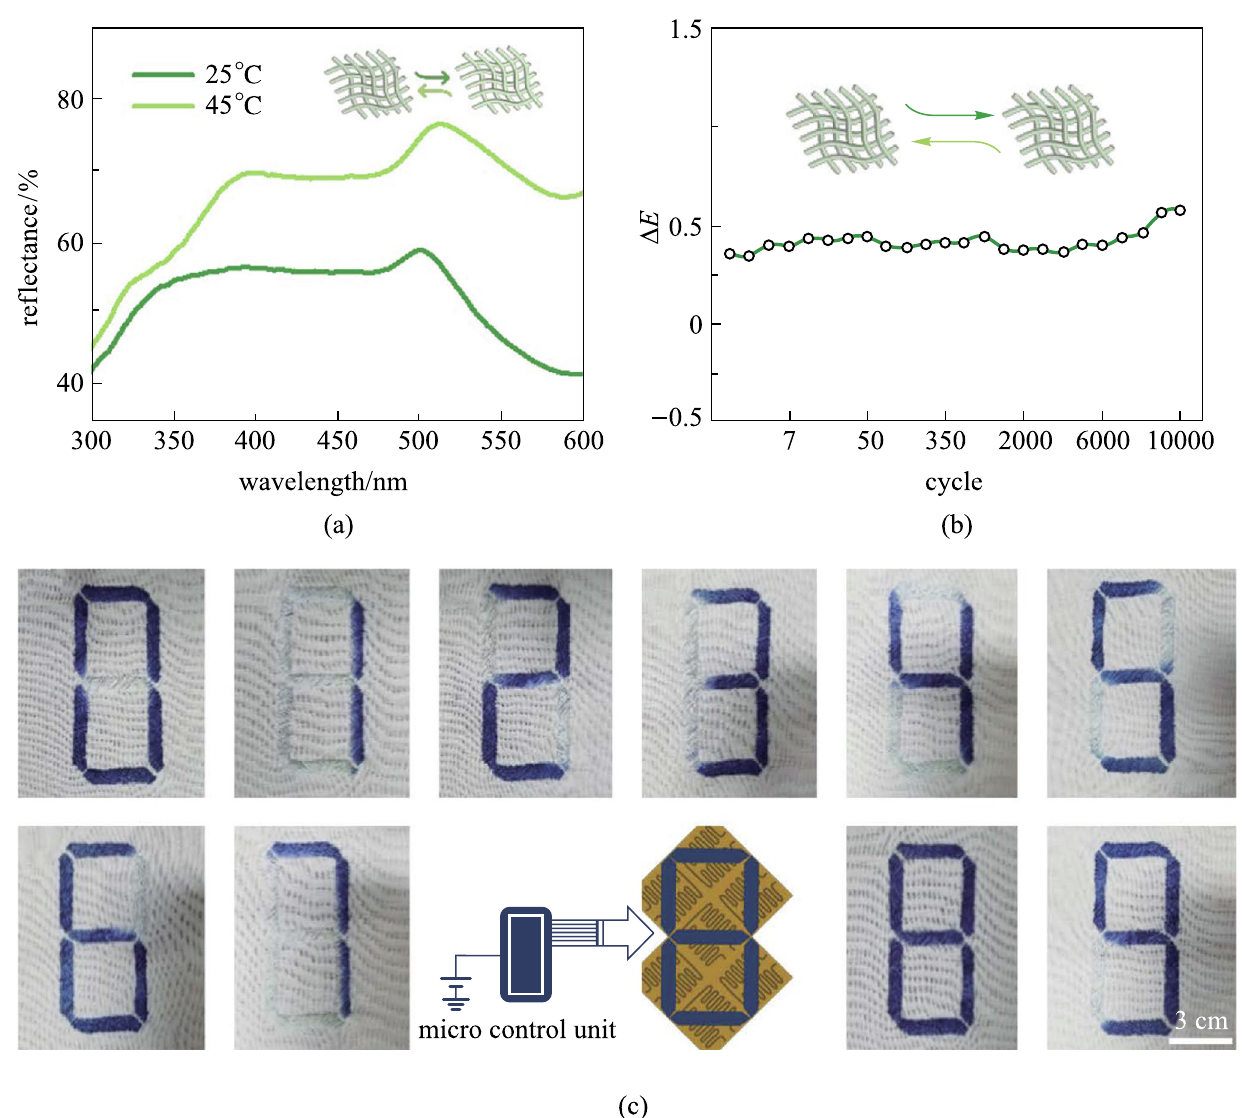
Fig. 3 Performance of thermochromic fabrics and fabric dynamic displays. a Reflection spectra of the thermochromic fabric at the temperature of 25 °C (dark green curve) and 45 °C (light green curve), respectively. b Relative colorimetric response changes over 10,000 thermal cycles between 25 °C and 45 °C. c Thermochromic fabric displaying numbers from 0 to 9, with color change temperature of 55 °C (scale bar: 3